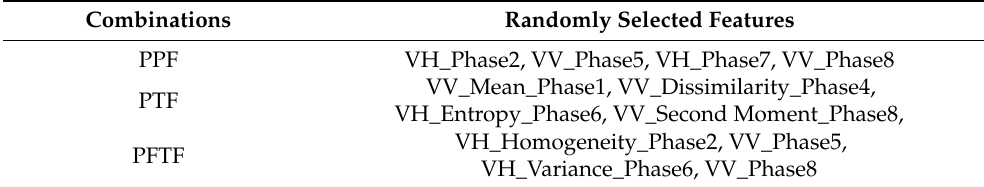
Table 5. A summary of selected SAR features on key growth stages of rice.